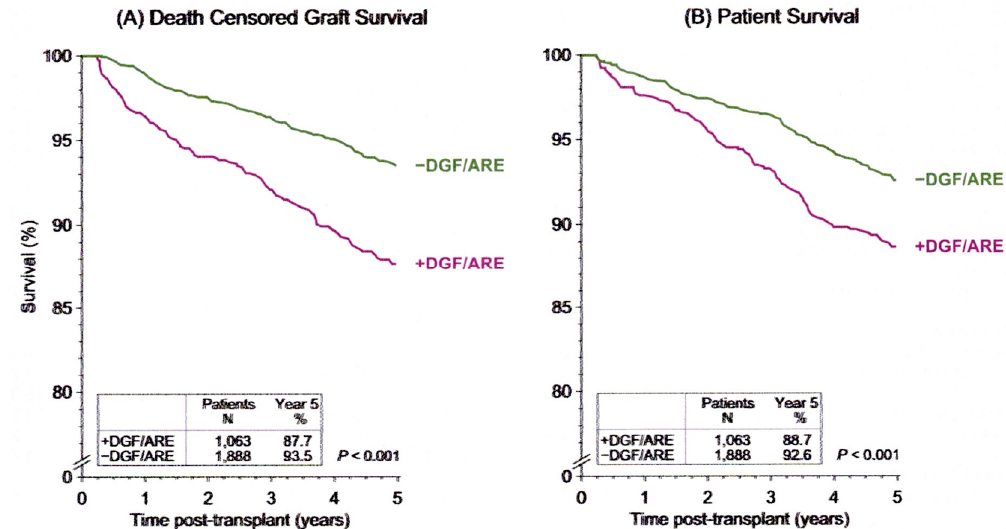
Figure 3. Influence of delayed graft function (DGF) and acute rejection (ARE) on ( A ) death-censored graft survival and on ( B ) patient survival in kidney transplantation from deceased donor. A group of patients without DGF and ARE (−DGF/ARE) was compared with a group of patients with both DGF and ARE (+DGF/ARE). Graft survival was calculated by censoring death patients. Patient survival was considered as the time from transplant to the patient’s death. Early adverse events had a significant impact on both death-censored graft survival as well as patient survival, with influence on death-censored graft survival more pronounced in patients DGF+/ARE+ (obtained from CTS newsletter, 4:2018, accessed 20/01/2020, www.ctstransplant.org).